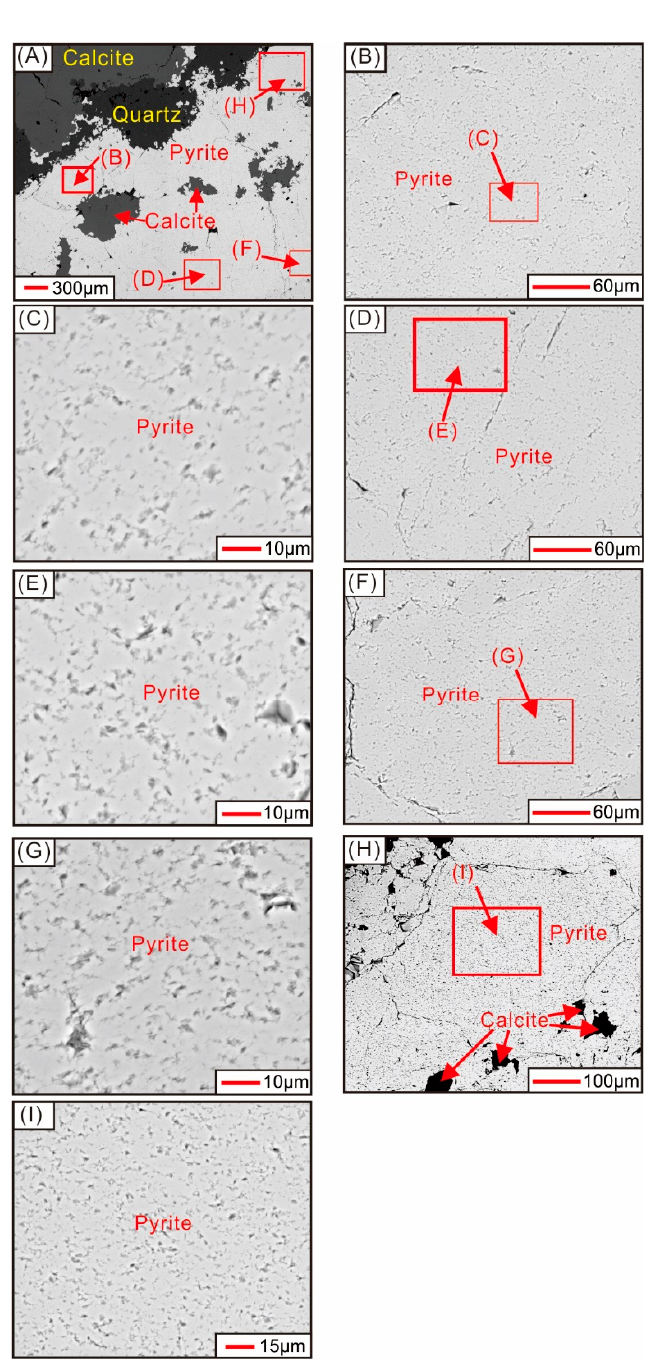
Figure 4. A typical SEM image of a thin section ( A ) shows the embayment structures between pyrite, calcite and quartz, suggesting that these minerals were precipitated contemporaneously from the hydrothermal fluid. High resolution SEM images ( B – I ) show that pyrites in this study are quite clean and free from mineral or fluid inclusions, suggesting that Rb and Sr mainly reside in the mineral lattices. ( B , D , F , H ) show the enlarged regions in ( A ). ( C , E , G , I ) show the enlarged regions in the ( B , D , F , H ), respectively. Locations of the enlarged regions are labelled in the corresponding figures.